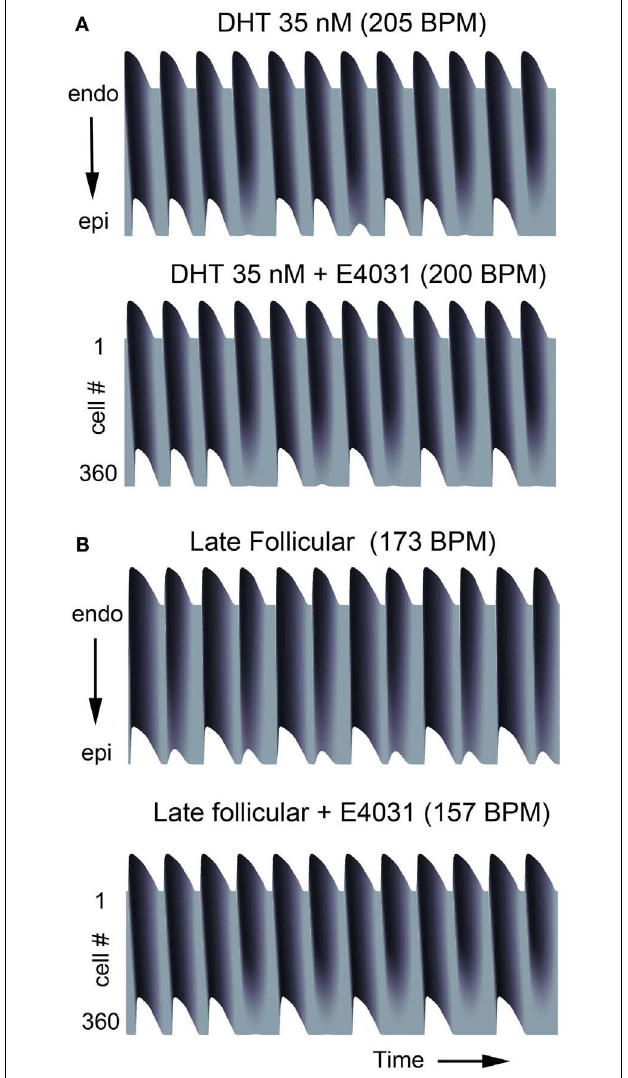
FIGURE 4 |Alternans occurs at slow pacing rates in female tissue. Transmural tissue composed of epi-/endocardial ventricular cells were paced at various cycle lengths. (A) Male with DHT 35nM and/or E-4031 10nM. (B) Female in late follicular phase (top) and with E-4031 10nM